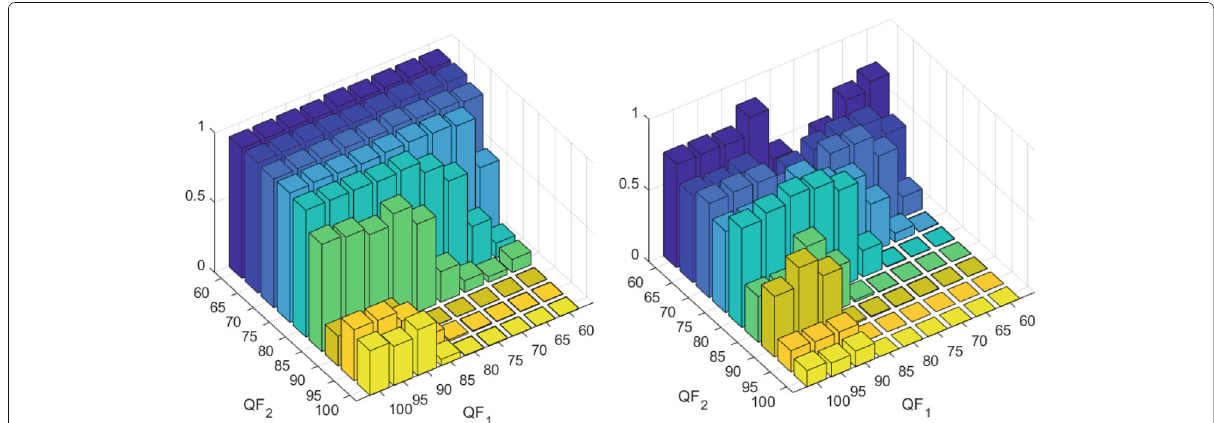
Fig. 10 Accuracy of our method (left) and [28] (right) on JPEG triple compressed images employing all the combinations QF 1 , QF 2 ∈ { 60,65,70,75,80,85,90,95,100 } and QF 3 = 90 considering QF 2 as ground truth